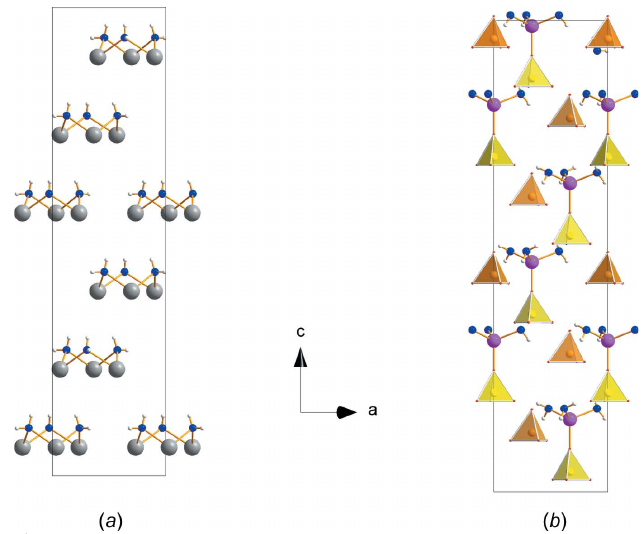
Figure 4 Stacking of ( a ) the trimeric Na 3 (H 2 O) 3 and ( b ) the Li(H 2 O) 3 (SO 4 ) units along the c axis within a unit cell. Additional SO 4 groups with the S2 sulfur atom are shown (dark yellow).